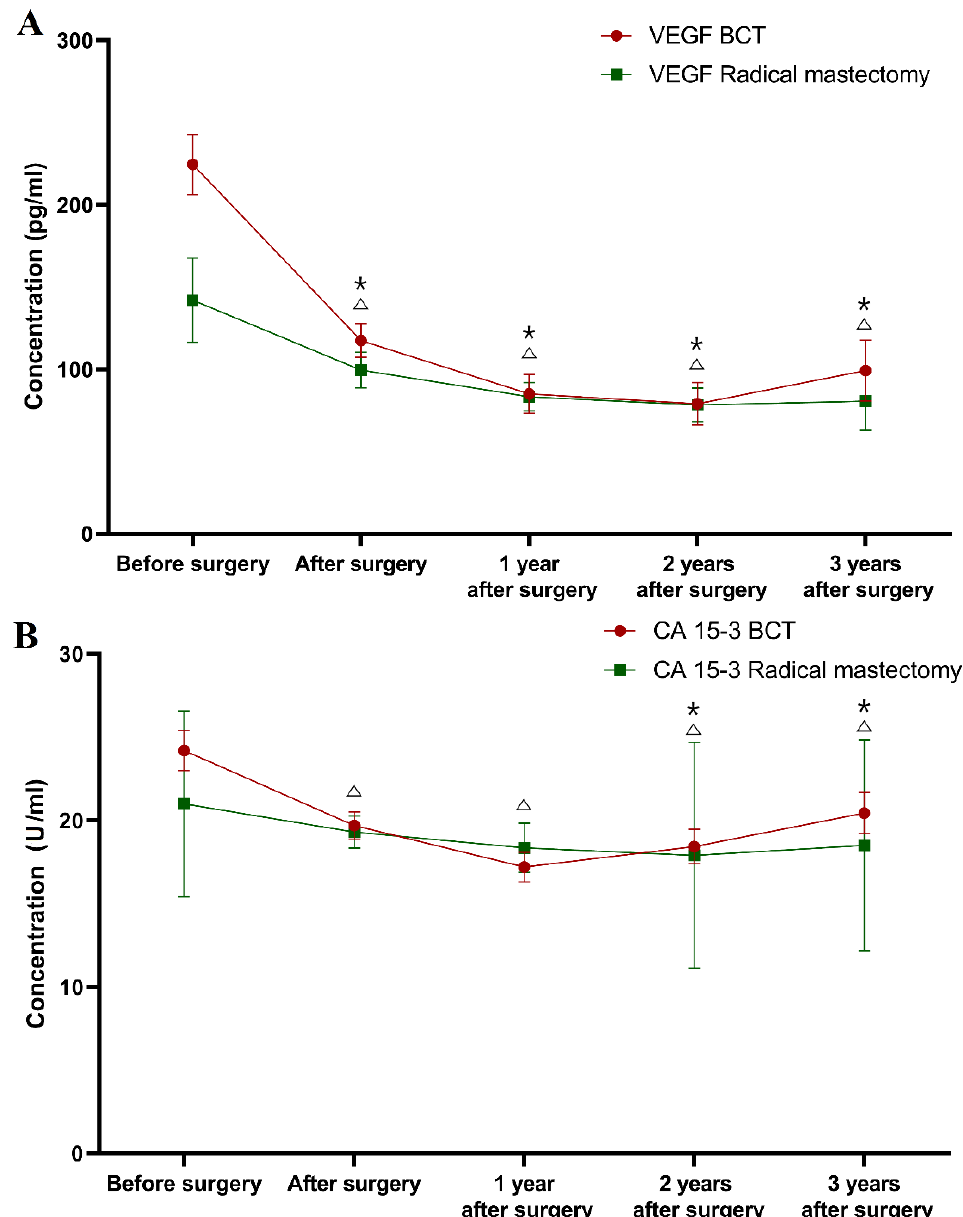
Figure 3. Plasma levels (median and standard error) of VEGF ( A ) and CA 15-3 ( B ) in a three-year follow-up of patients with breast cancer, according to the type of surgery. * statistically significant difference from preoperative levels in BCT group, (cid:52) statistically significant difference from preoperative levels in radical mastectomy group.